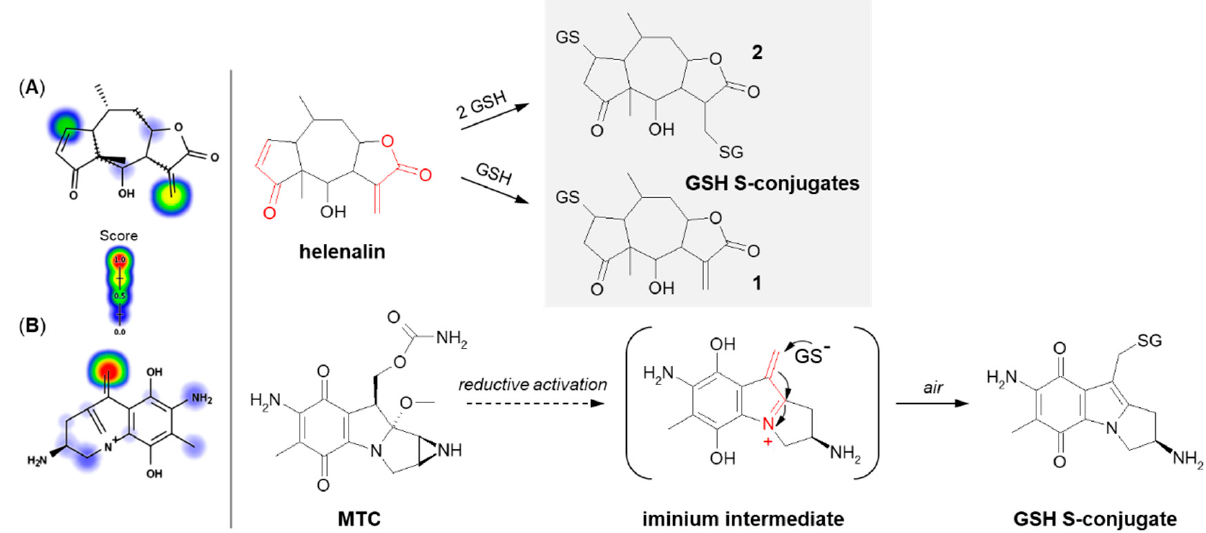
Figure 15. Reaction schemes of ( A ) helenalin [131] and ( B ) mitomycin C (MTC) [133] conjugation with GSH. The Michael acceptor moieties are marked in red. Predicted bioactive sites of GSH conjugation for anticancer drugs were obtained by XenoSite Reactivity Predictor available at https://swami.wustl.edu/xenosite/p/reactivity (accessed on 18 May 2022).